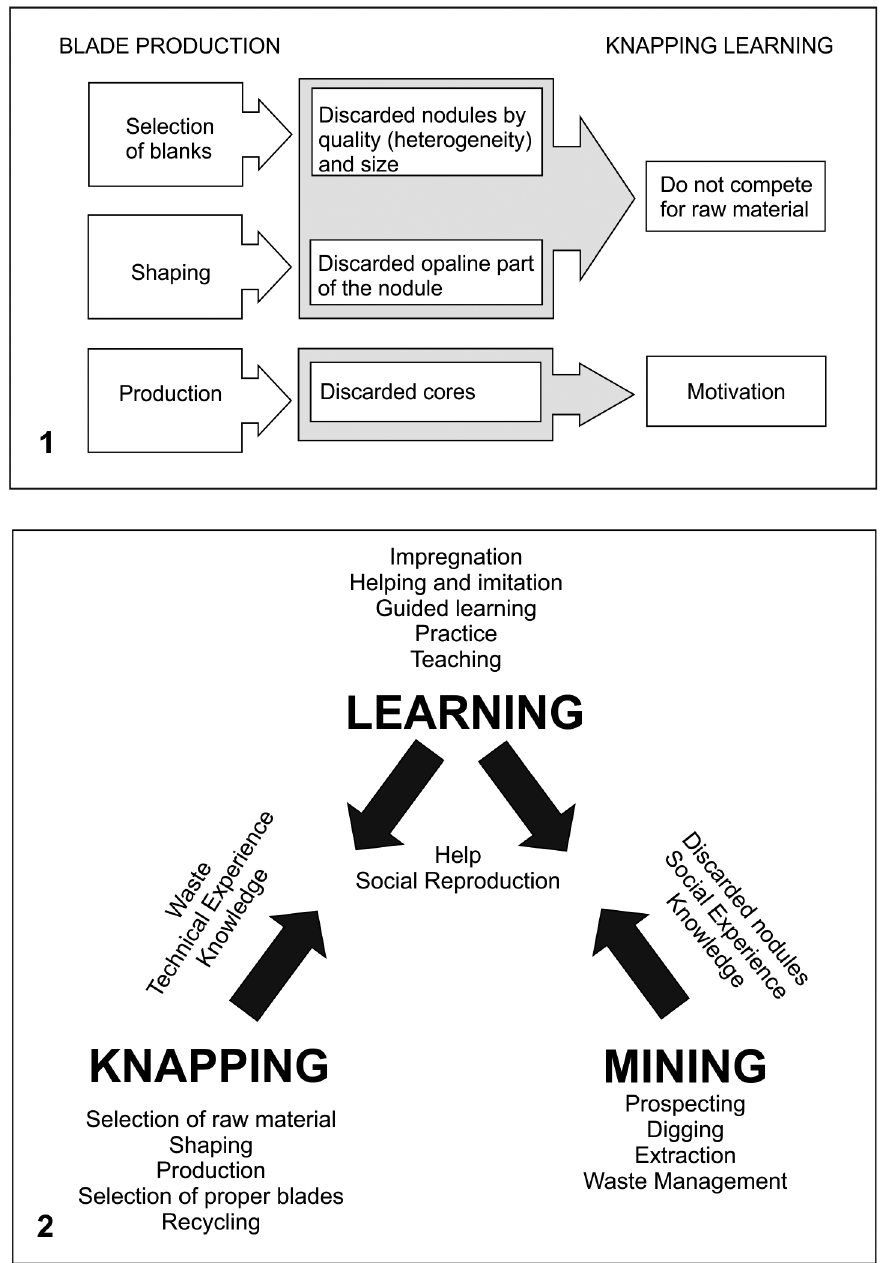
Figure 7: ( 1 ) Knapping learning raw material selection sources from blade production waste and ( 2 ) relationship between mining, knapping, and